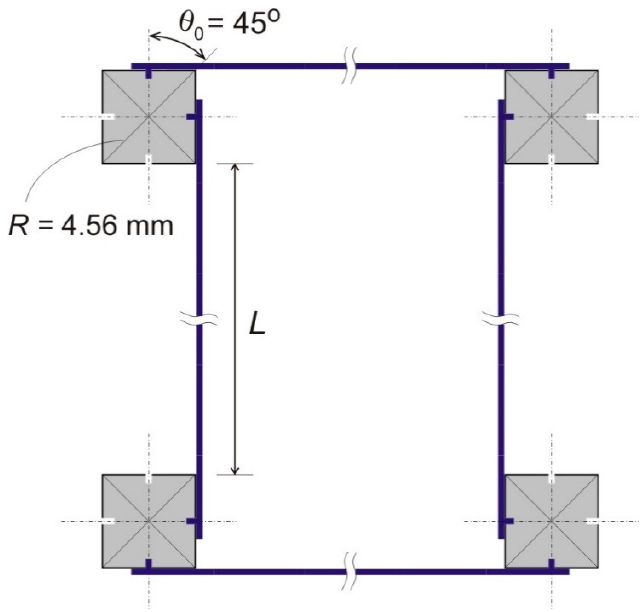
Figure 11. Schematic diagram of a representative unit cell in fabricated samples. Square nodes imply a chirality angle, θ 0 = 45 ◦ . Three different values of the length L were utilized.